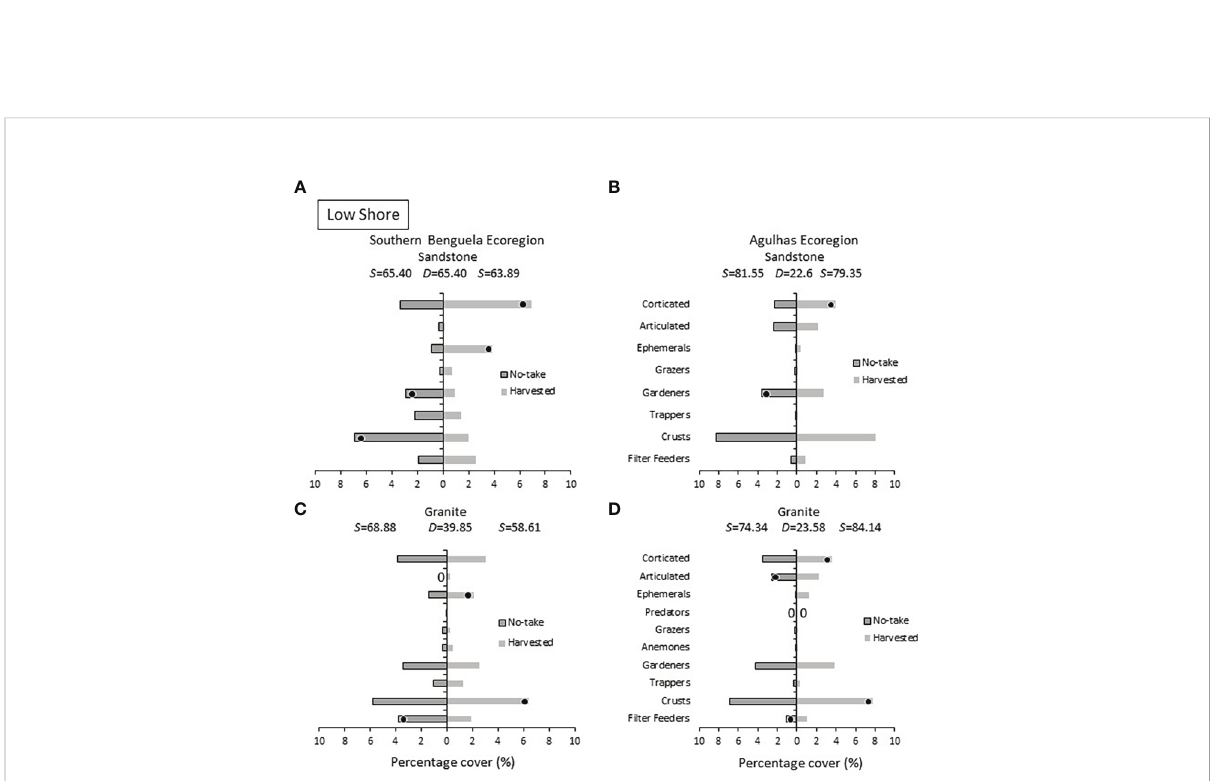
FIGURE 6 Low shore: Percentage cover of groups responsible for the similarities ( S ) within harvested or no-take areas and the dissimilarities ( D ) between them, on sandstone in (A) the Southern Benguela and (B) in the Agulhas Ecoregion, and on granite in (C) the southern Benguela and (D) Agulhas. Black dots identify groups distinguishing between harvesting and no-take zones and are placed in the zone with the greatest abundance; 0 =